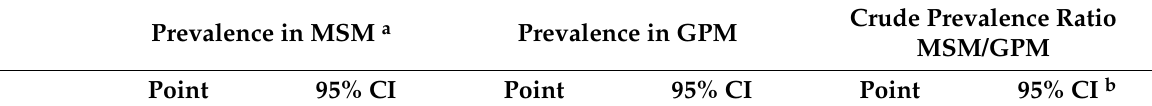
Table 2. Comparison of psychoactive substance use prevalences by last-year and lifetime use between men who have sex with men (MSM) and general-population men (GPM) in Madrid and Barcelona, 2018–2020